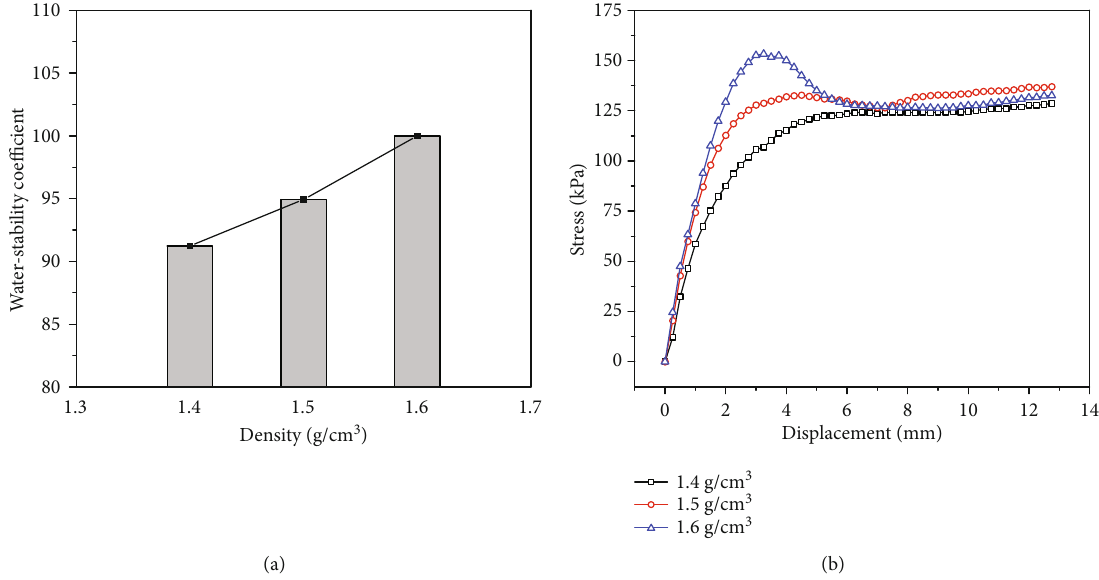
Figure 4: (a) The e ff ect of density on the water-stability coe ffi cient; (b) the typical direct shear stress-displacement curves.